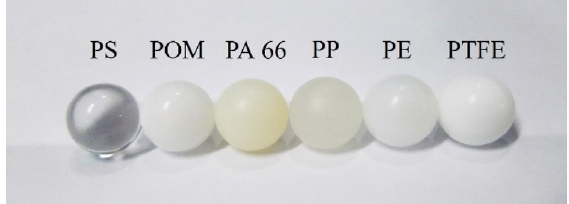
Fig. 1 Appearance of the six kinds of polymer spheres.